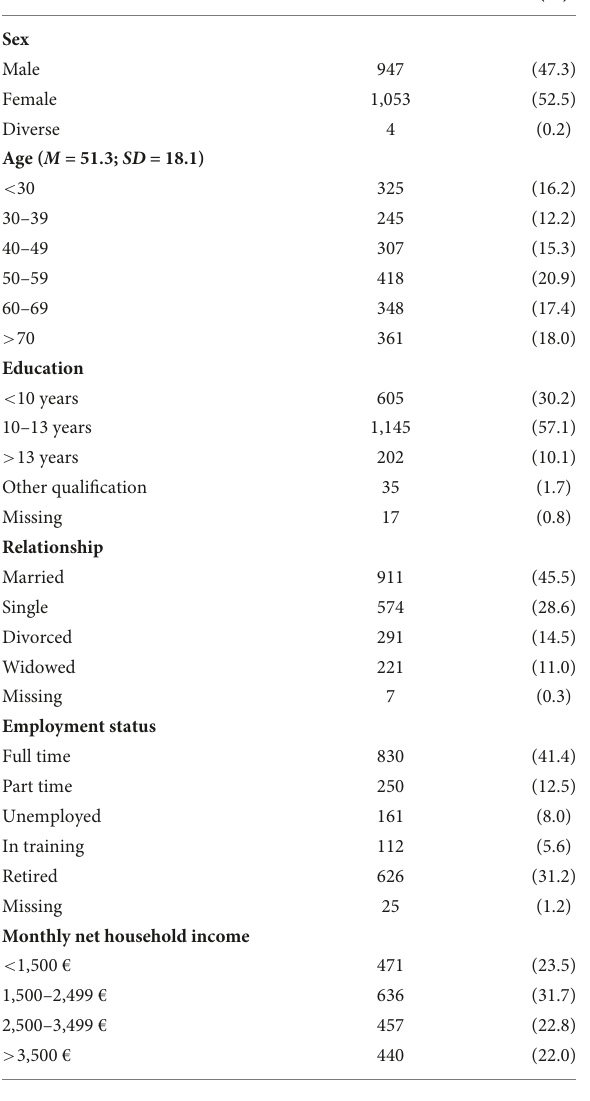
TABLE 1 Sociodemographic characteristics— N = 2,004. TABLE 2 Mean numbers of ACEs as well as mean values of ITQ (symptoms of PTSD and cPTSD, respectively), OPD-SQS (personality functioning), and ETMCQ (epistemic trust)— N =